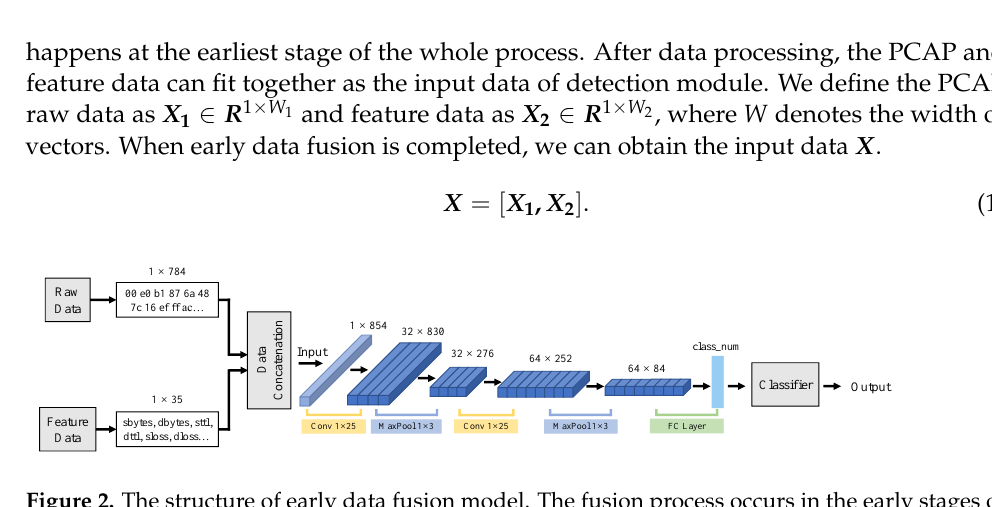
Figure 2. The structure of early data fusion model. The fusion process occurs in the early stages of the detection process, which can be regarded as the direct fusion of raw data